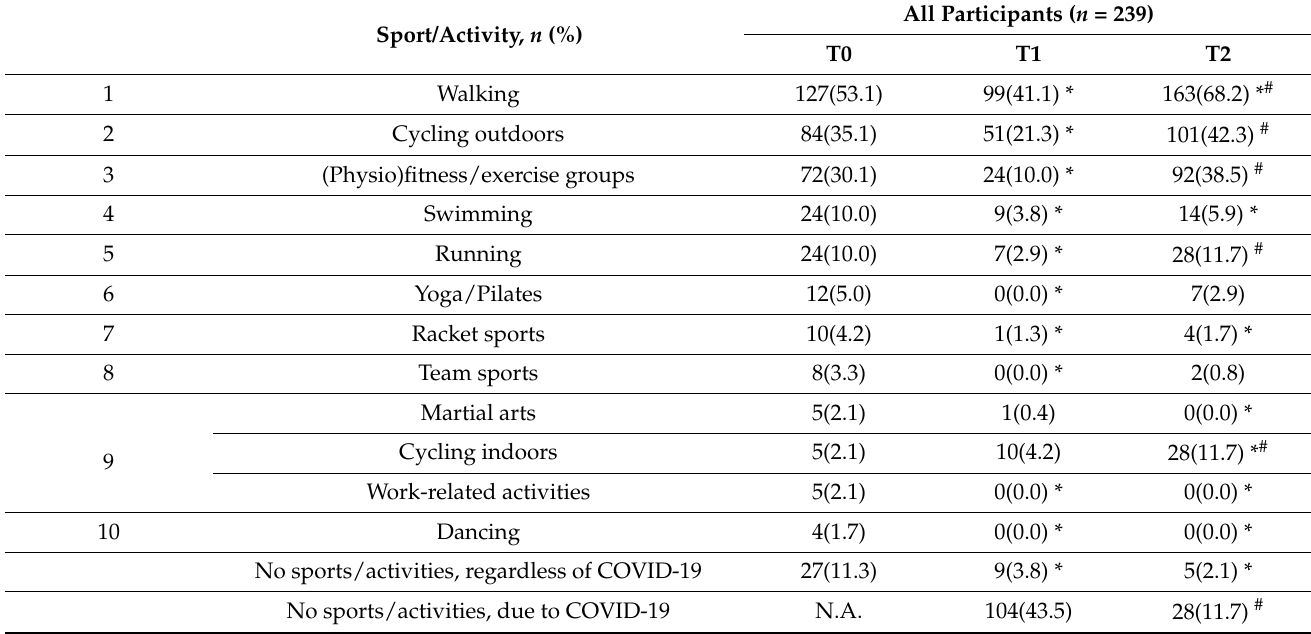
Table 2. Activities performed by participants before (T0) and at three (T1) and six months (T2) of